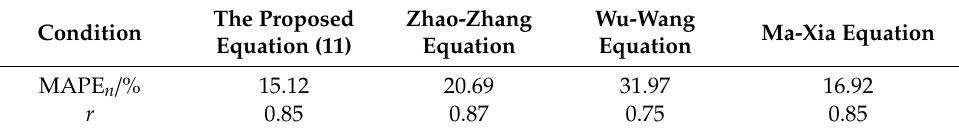
Table 4. Performance of different flow resistance equations with the LYR validation data. Condition